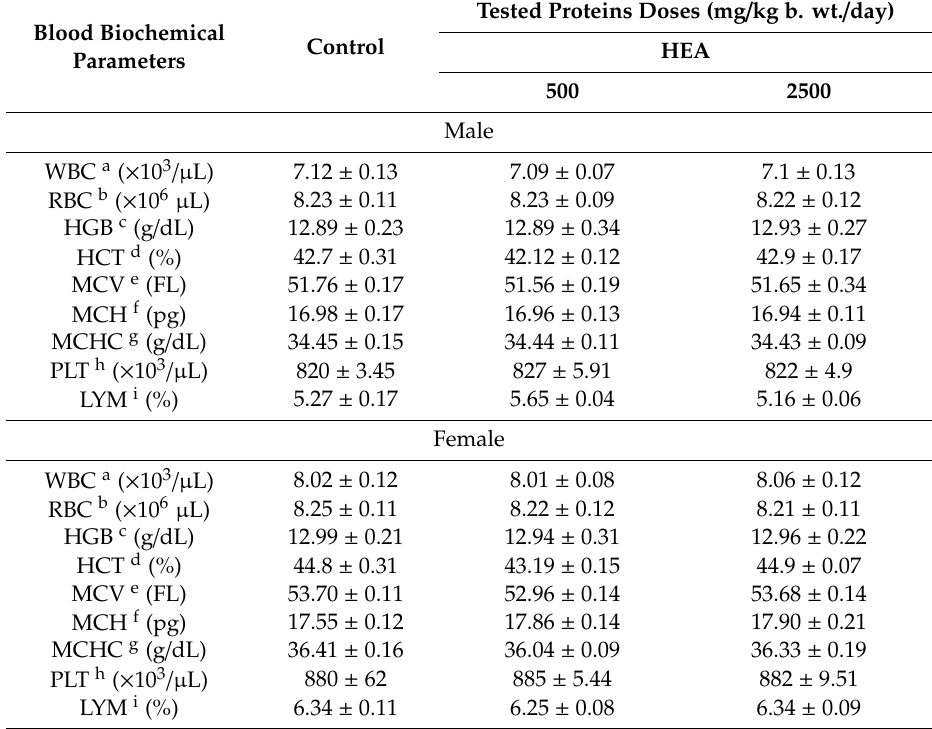
Table 6. E ff ect of hydrolyzed egg albumin (HEA) on hematological parameters of male and female albino rats treated orally daily for 28 days. Blood Biochemical Parameters